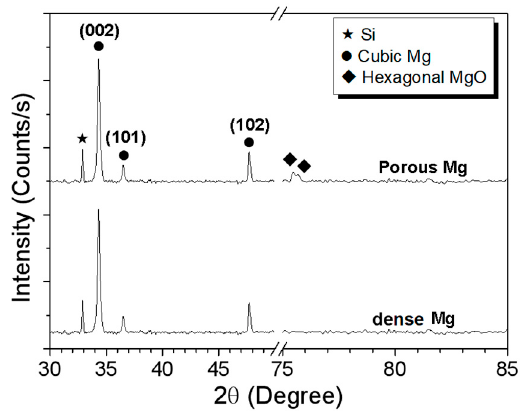
Figure 4. XRD spectra of the Mg films prepared for α = 0 ◦ and P Tot = 0.26 Pa (dense Mg) and for α = 85 ◦ Figure 4 . XRD spectra of the Mg films prepared for α = 0°and P Tot = 0.26 Pa (dense Mg) and for α = 85° and P Tot = 0.26 Pa (porous Mg). In both cases, the sputtering power is 50 and P Tot = 0.26 Pa (porous Mg). In both cases, the sputtering power is 50 W.